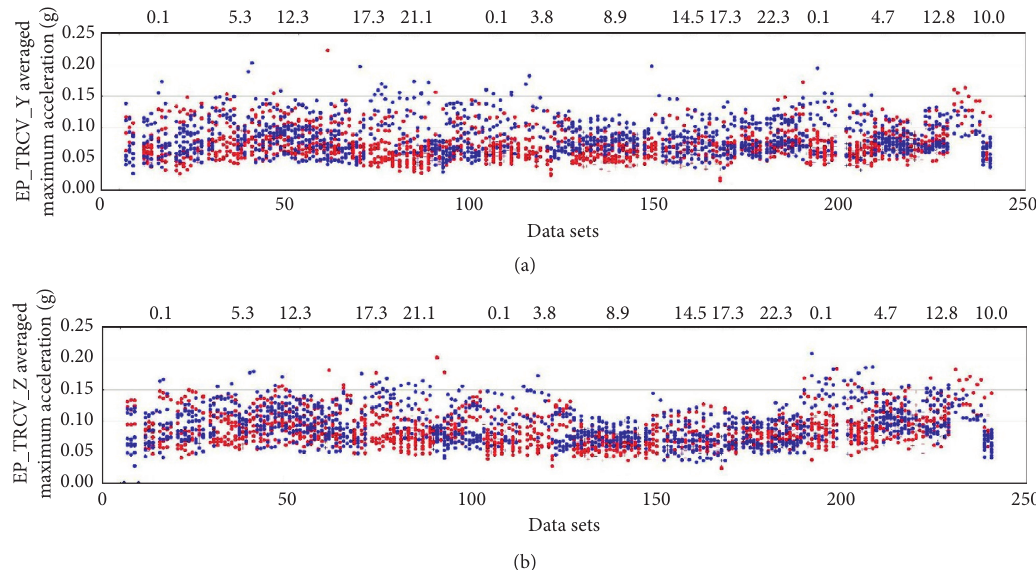
Figure 10: Low-pass filtered (15 Hz) acceleration on CBSE traction transformer in (a) lateral and (b) vertical directions.